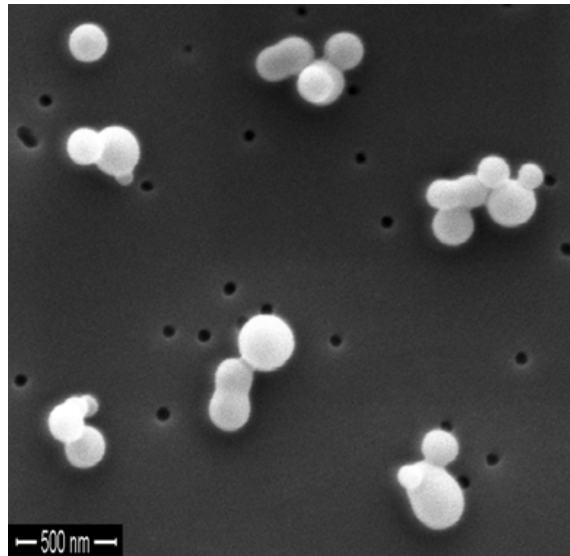
Fig. 5. FEG-SEM image of secondary organic aerosol particles on a polycarbonate filter: nearly perfect spherical particles with no visible surface texture form chain- and cluster-like aggregates. The spherical particles range in diameter from about 80 to 300 nm caused by an increased precursor concentration.